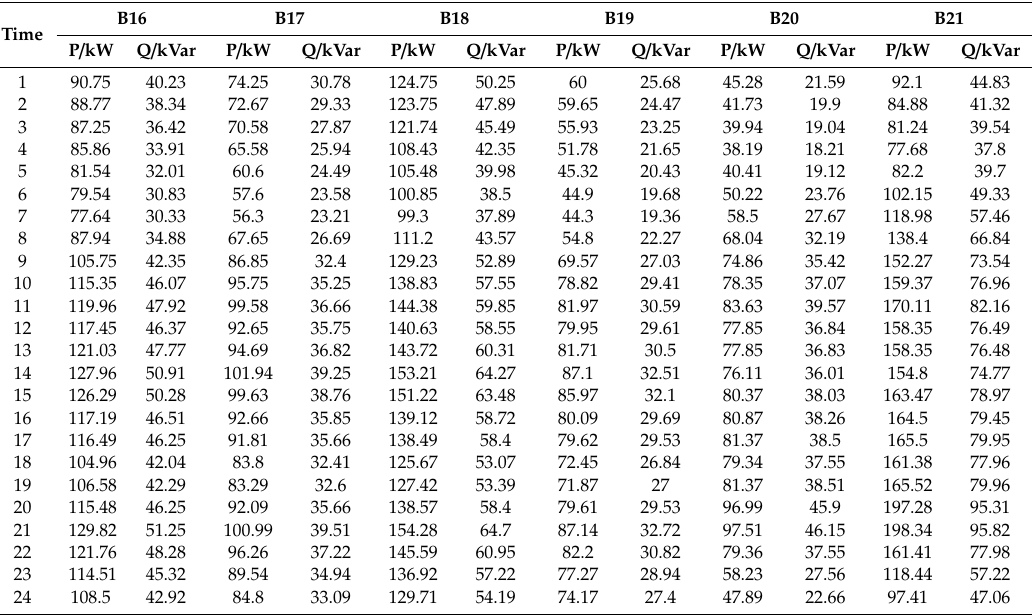
Table A3. The bus load at di ff erent time of nodes 16–21.